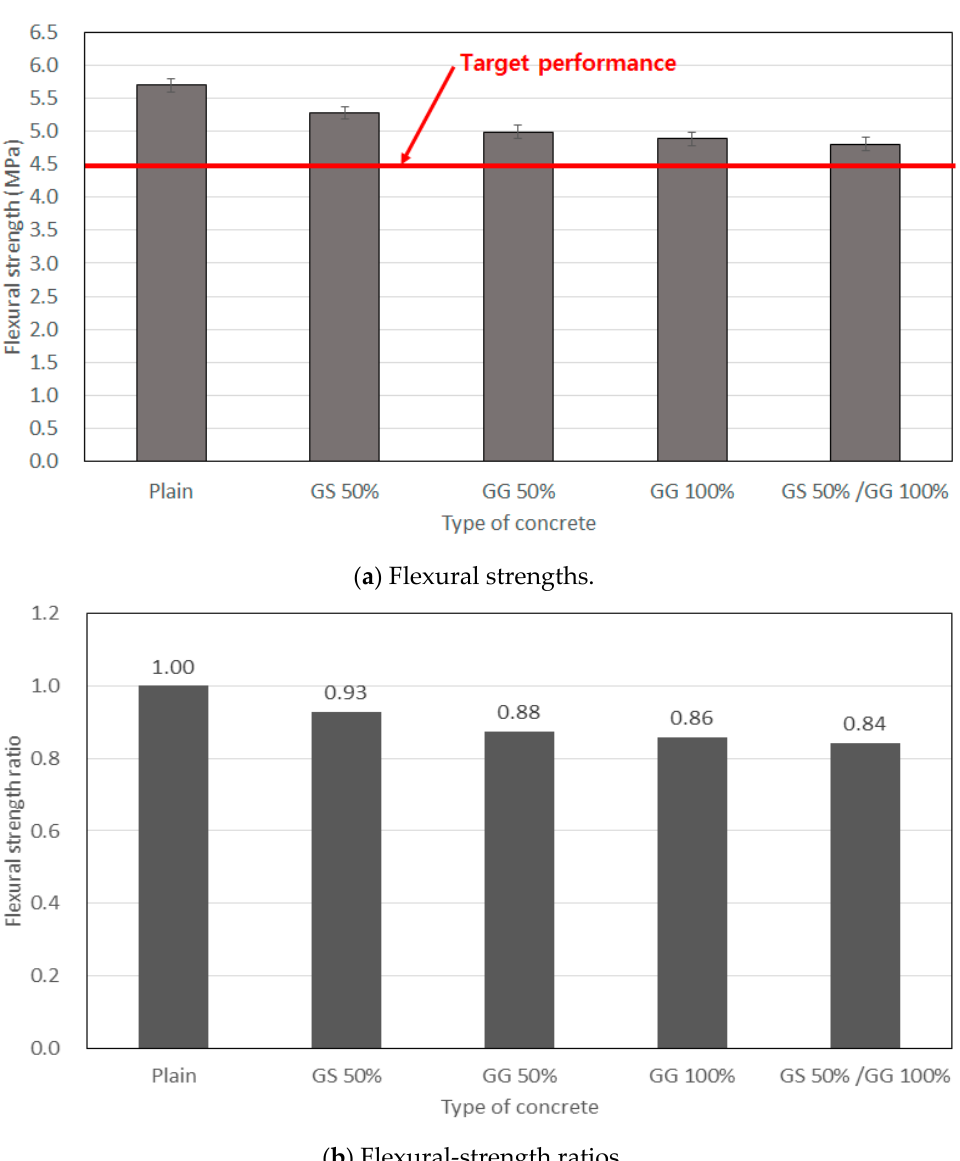
Figure 5. Test results for flexural strength.